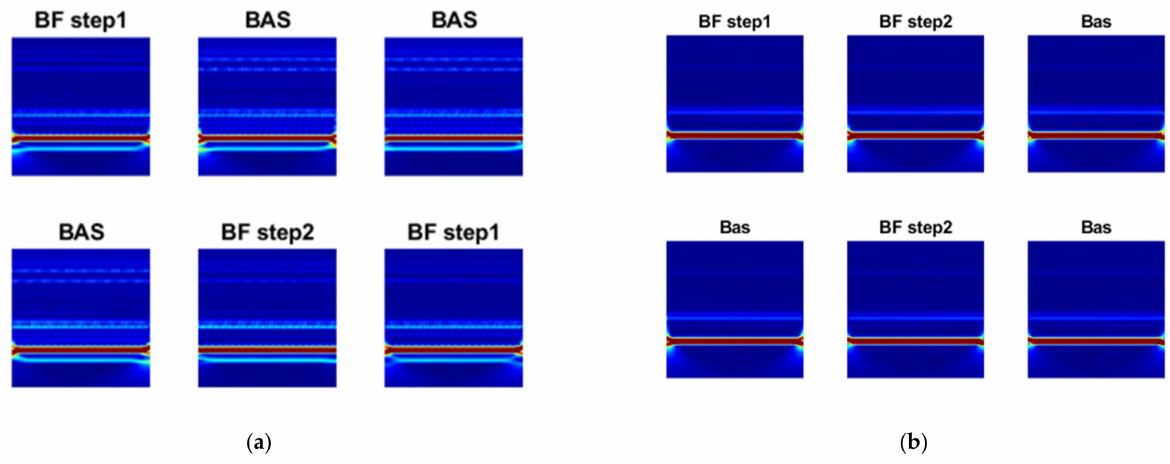
Figure 5. Some samples of training images generated from the CWT: ( a ) radial flux signal and ( b ) current